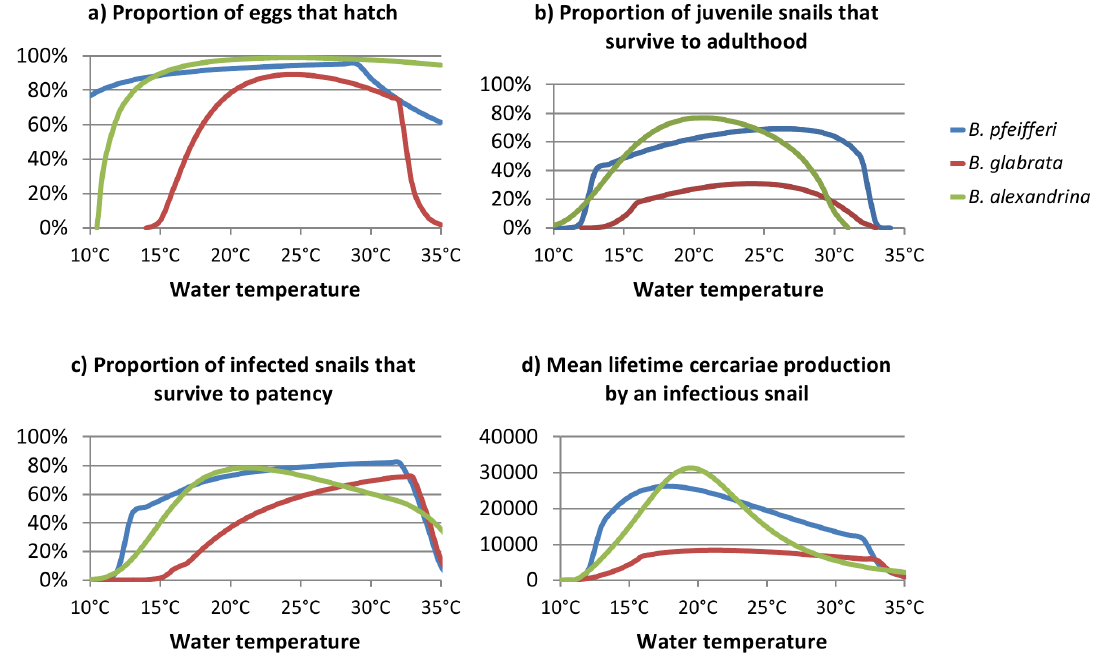
Figure 4. Proportions of eggs and snail surviving each stage, and cercariae production by infected snails. a) Proportion of eggs laid that hatch. b) Proportion of juvenile snails that survive to adulthood (assuming no additional density dependent mortality, and that no juvenile snails develop patent infections before they become adults). c) Proportion of infected snails that survive to patency (assuming no additional density dependent mortality). d) Median lifetime cercariae production by an infectious snail (assuming no additional density dependent mortality). Results are shown for the lower mortality scenarios. Blue lines show B. pfeifferi , red lines show B. glabrata and green lines show B. alexandrina.